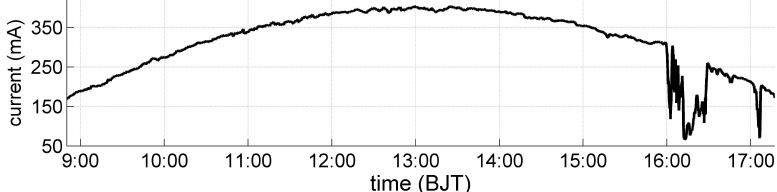
Figure 7. The total solar irradiance measured by the average output current (mA) of the five solar panels mounted on top of the